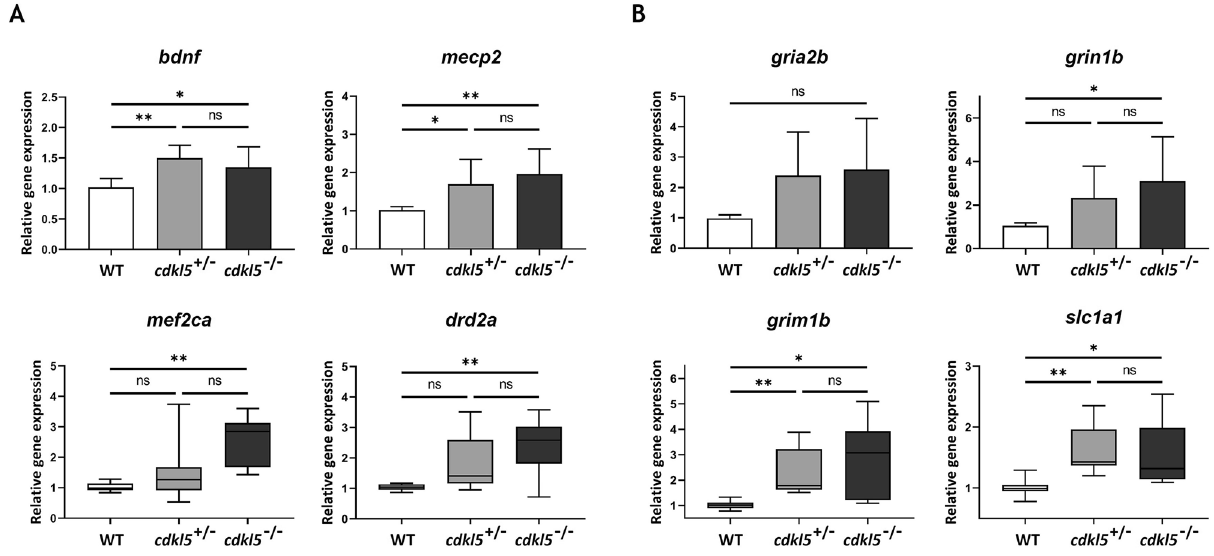
Figure 7. Molecular analysis of cdkl5 sa21938 mutants. Relative gene expression analysis of neuronal markers ( A ), including glutamatergic neurotransmission markers ( B ) in wild-type (WT), heterozygous ( cdkl5 +/− ), and homozygous ( cdkl5 −/− ) mutant zebrafish embryos at 5 dpf, measured by qPCR. For bdnf , mecp2 , gria2b and grin1b , values are presented as mean ± SD and statistical analysis was performed using one-way ANOVA followed by Tukey’s test. For mef2ca , drd2a , grim1b and slc1a1 , data are presented as median with interquartile range and statistical analysis was performed using Kruskal–Wallis followed by Dunn multiple comparisons test. At least three independent experiments were performed. *, and ** indicate p < 0.05 and p < 0.01, respectively. ns indicates not